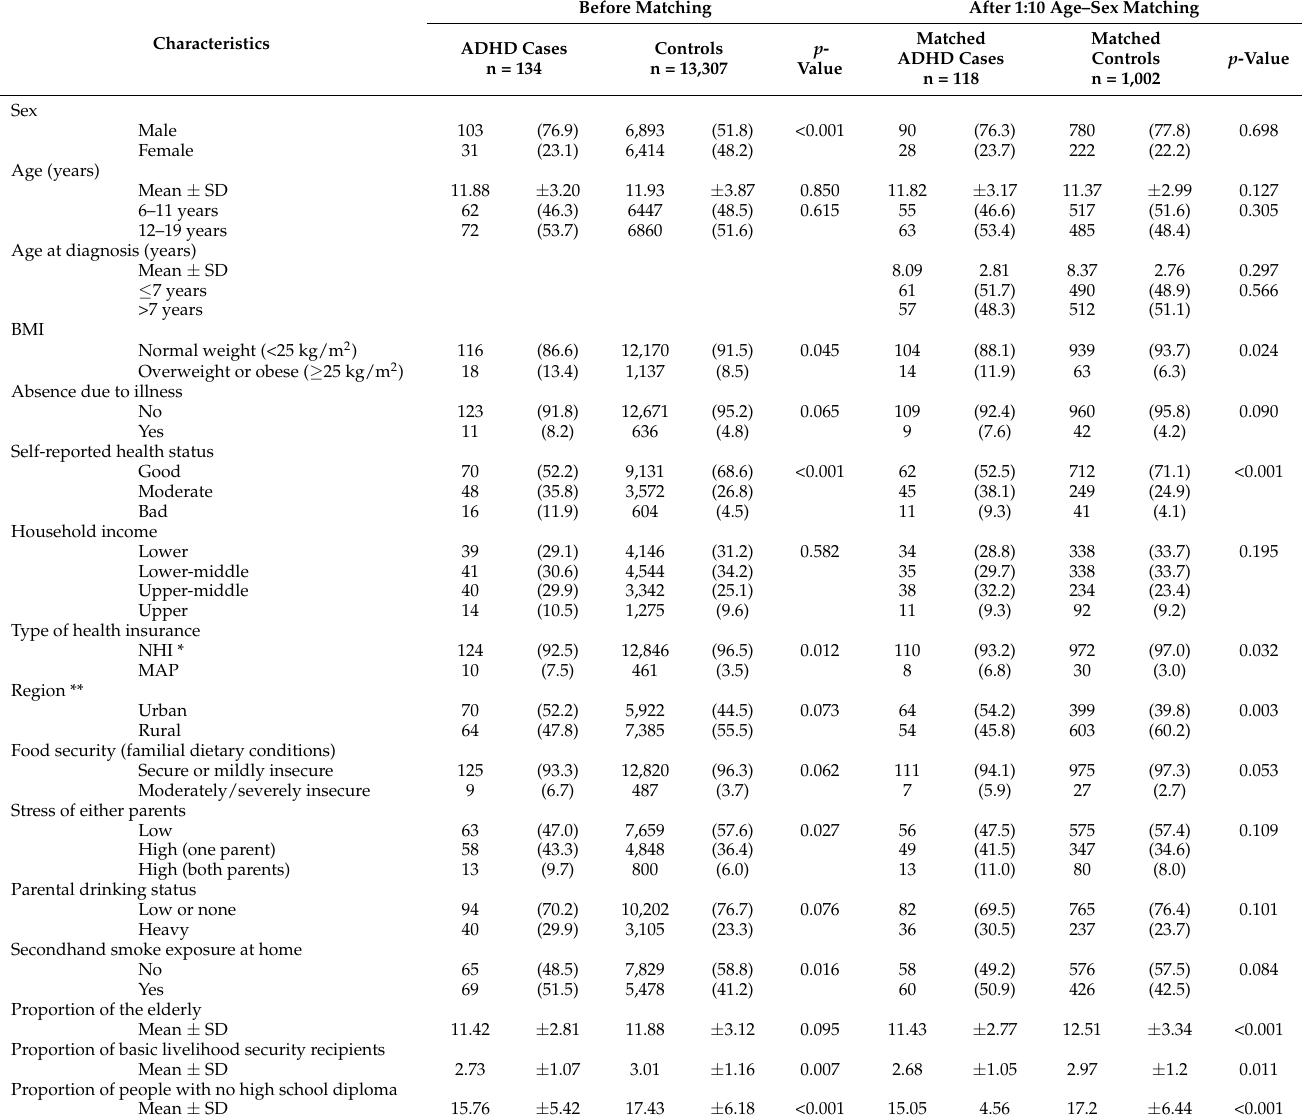
Table 1. Descriptive characteristics of the study group aged 6–19 years from KNHANES